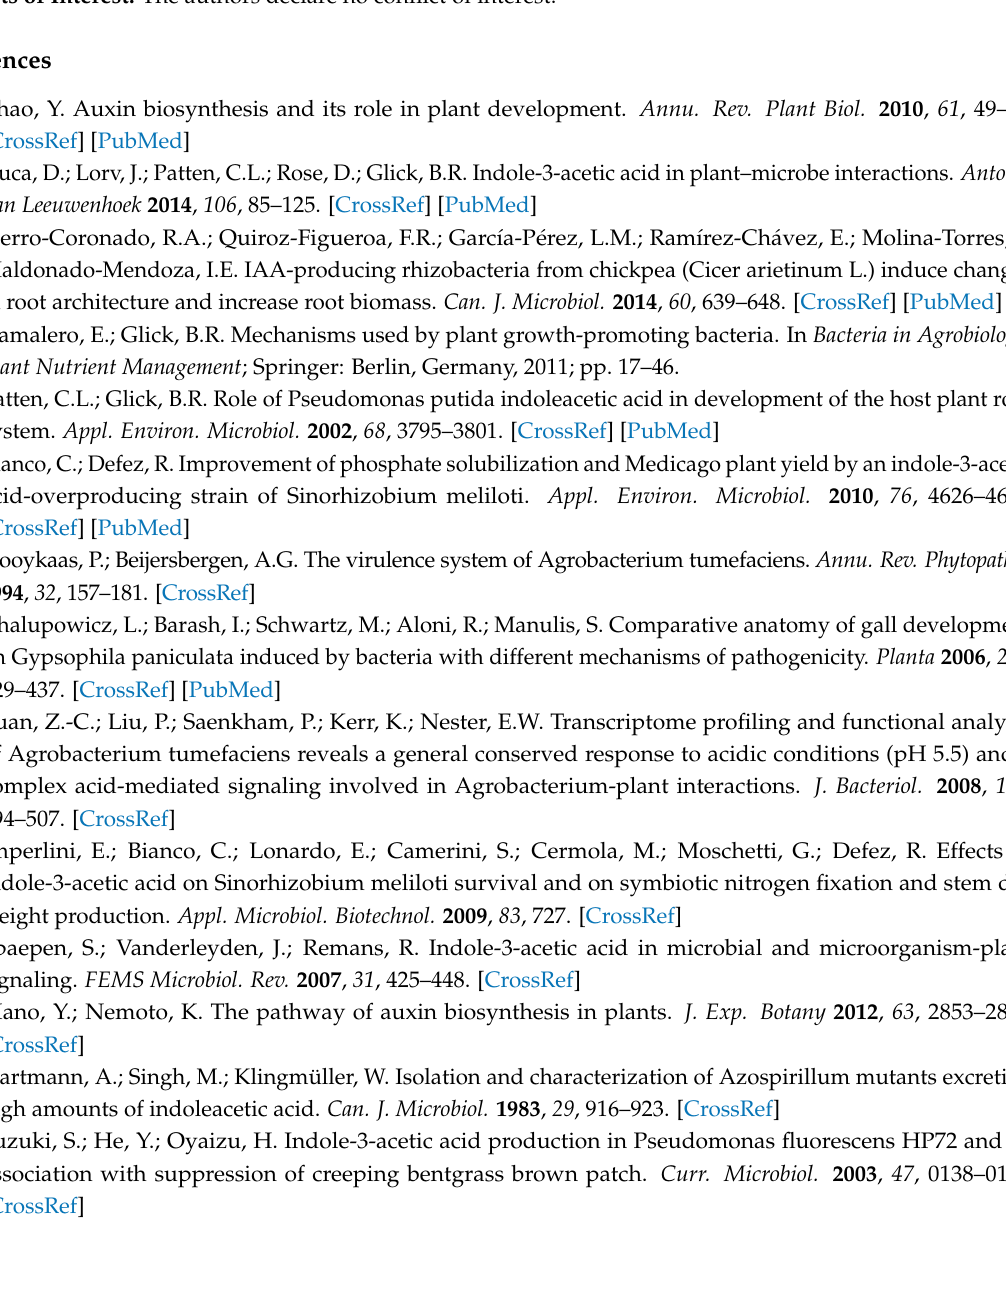
s1, Figure S1: Rarefaction curves displaying the number of combinations of IAA synthesis routes in each phylum, Figure S2: The bacterial taxonomic compositions of IAA synthesis-related genes in rhizosphere, Figure S3: The comparison of IAA synthesis capacity between metagenomic bins and retrieved genomes, Table S1: The number of genomes possess IAA-synthesis related enzymes in each pathway, Table S2: The number of genomes in each phylum own multiple coexisting pathways, Table S3: The number of genomes contain complete synthesis pathways, Table S4: The different combinations of synthesis pathways in each phylum, Table S5: The taxonomic assignments of metagenomic bins, Table S6: The ftp downloading paths of retrieved genomes, Table S7: The KOs scanned in each synthesis